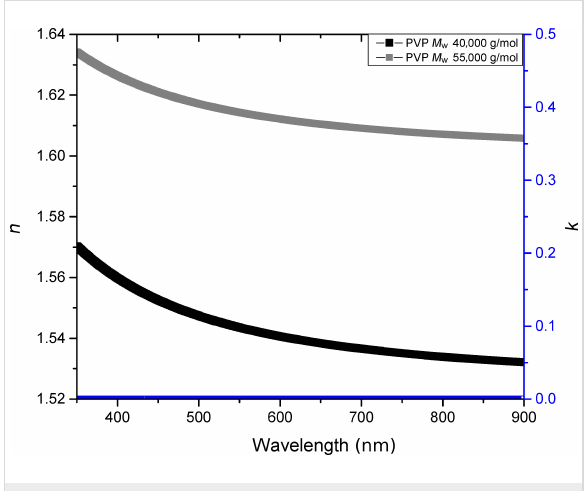
Figure 2: Real and imaginary optical indices of PVP of 40,000 and 55,000 g·mol − 1 average molar weight, fitted by a non-absorbing Cauchy